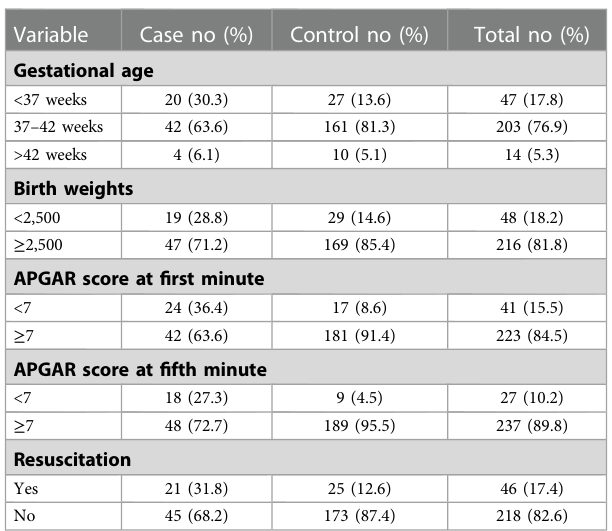
TABLE 2 Maternal characteristics of cases and controls attending Hawassa University Comprehensive Specialized Hospital and Adare General Hospital, Hawassa city, Ethiopia, 2018.